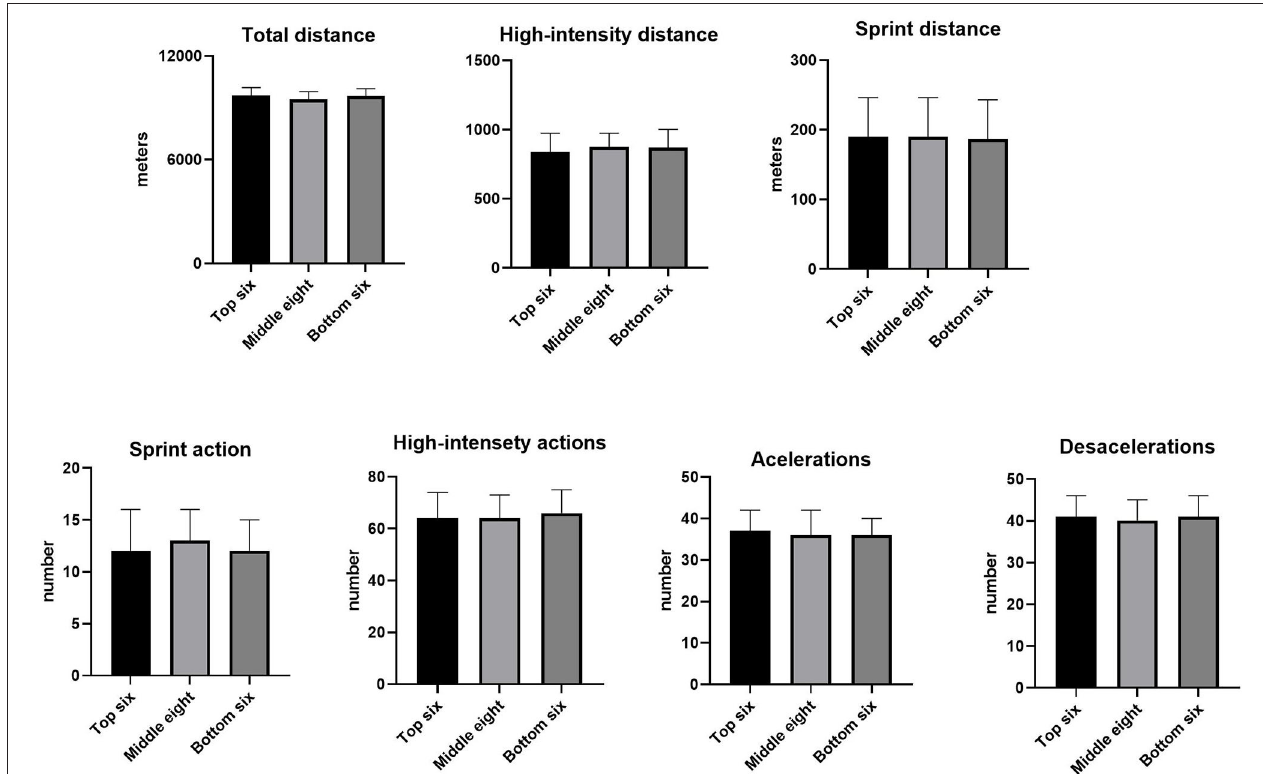
FIGURE 3 | Running performance differences according to opposition ranking in Brazilian elite professional soccer